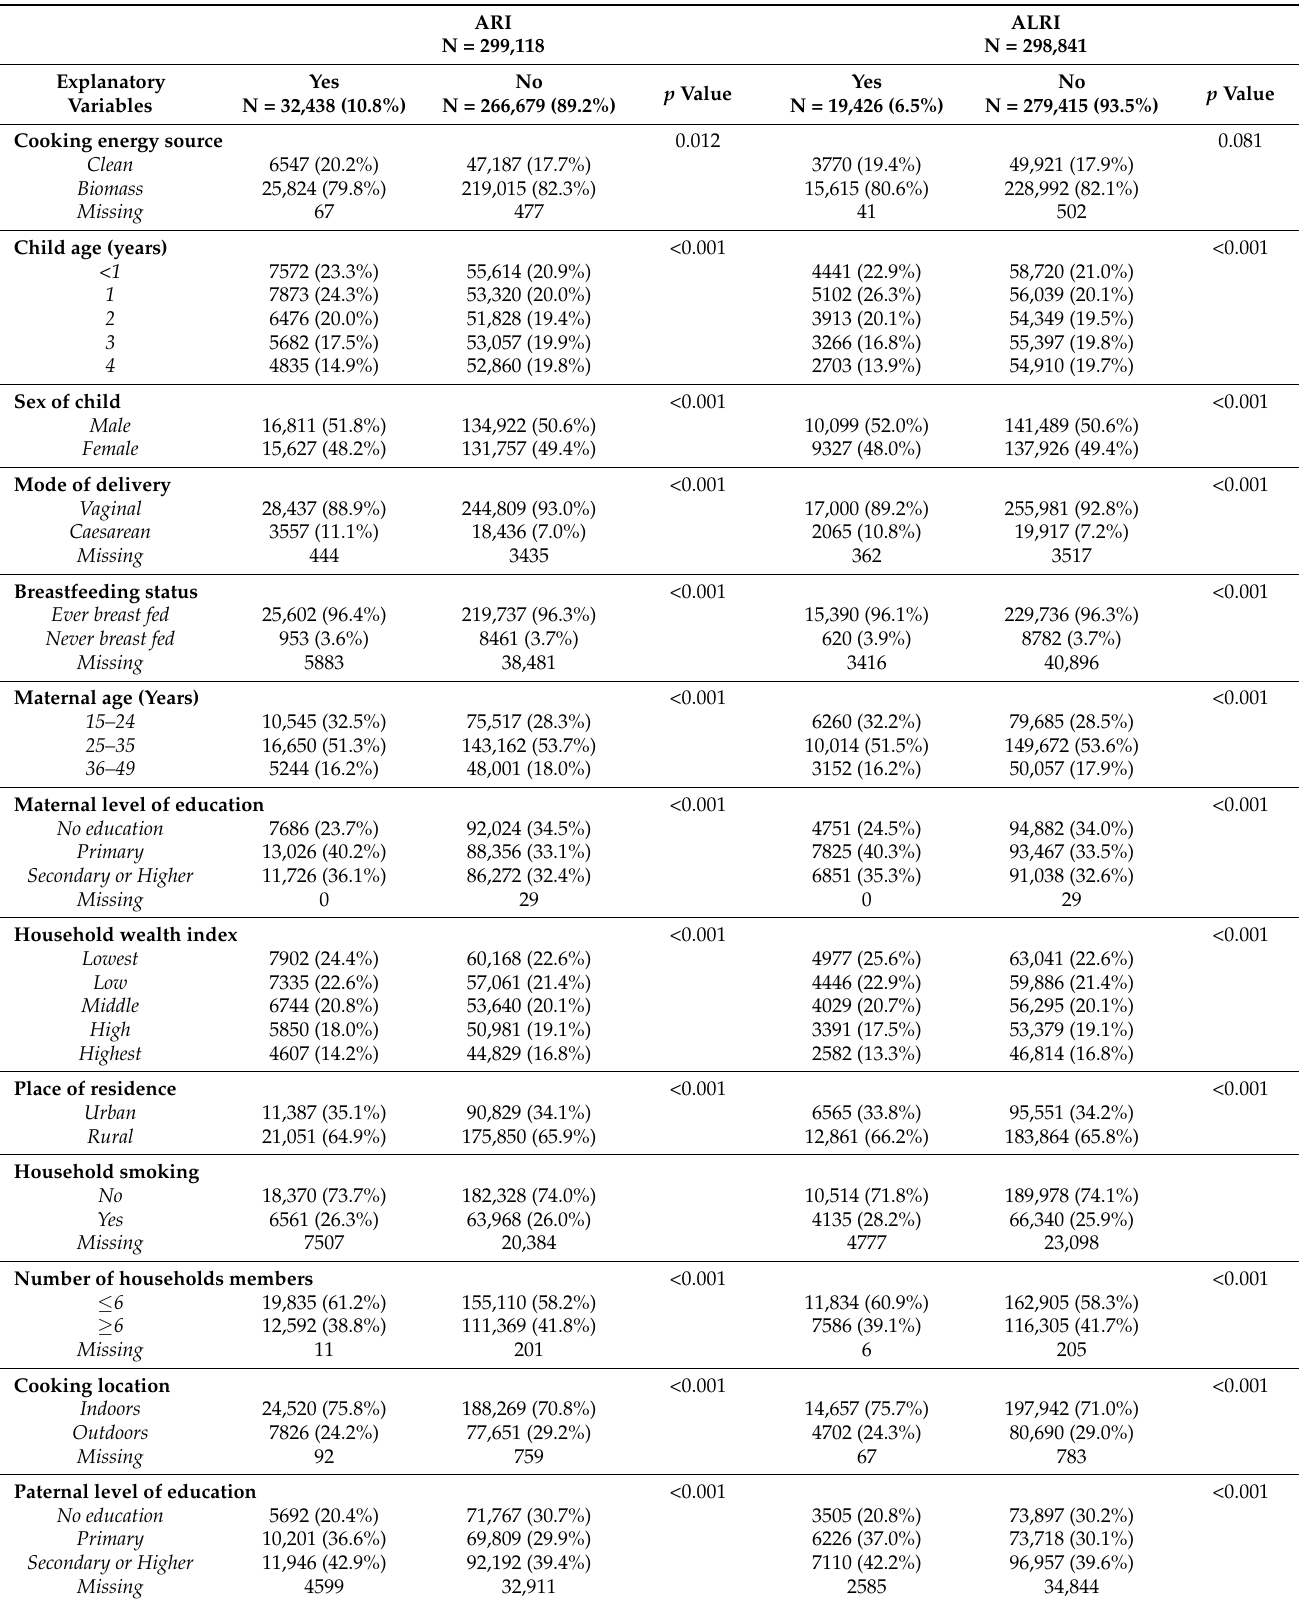
Table 1. Descriptive statistics for ARI and ALRI within the pooled dataset (N =